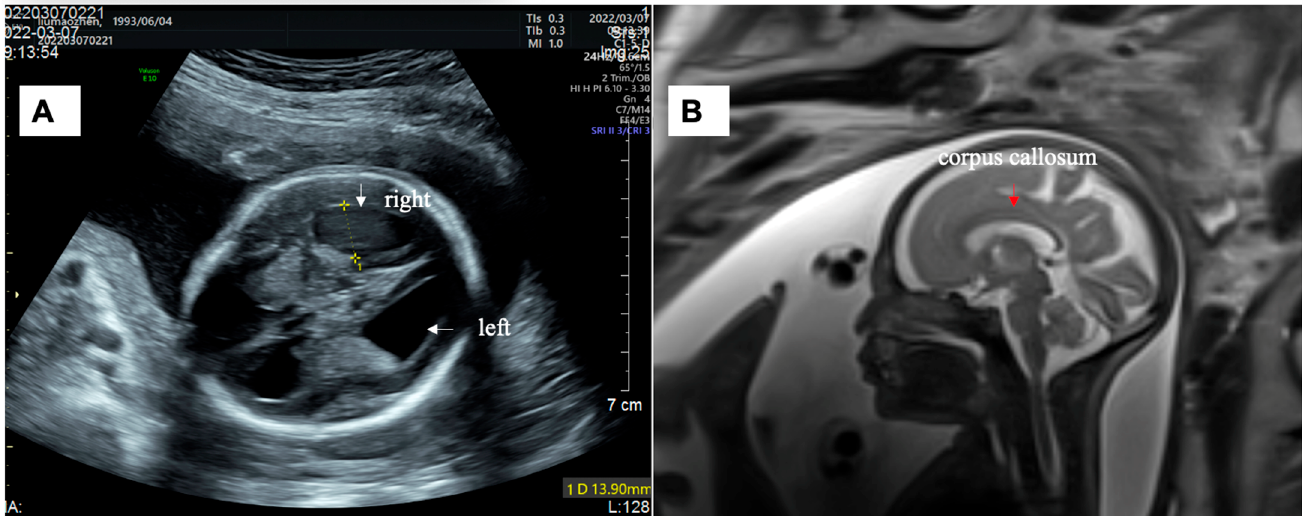
Figure 1. ( A ) Sonographic images of Fetus 1 showing lateral ventriculomegaly (left: 15.1 mm; right: 15.5 mm) at the 26-week scan. ( B ) Brain MRI images showing absence of the splenium of corpus callosum.